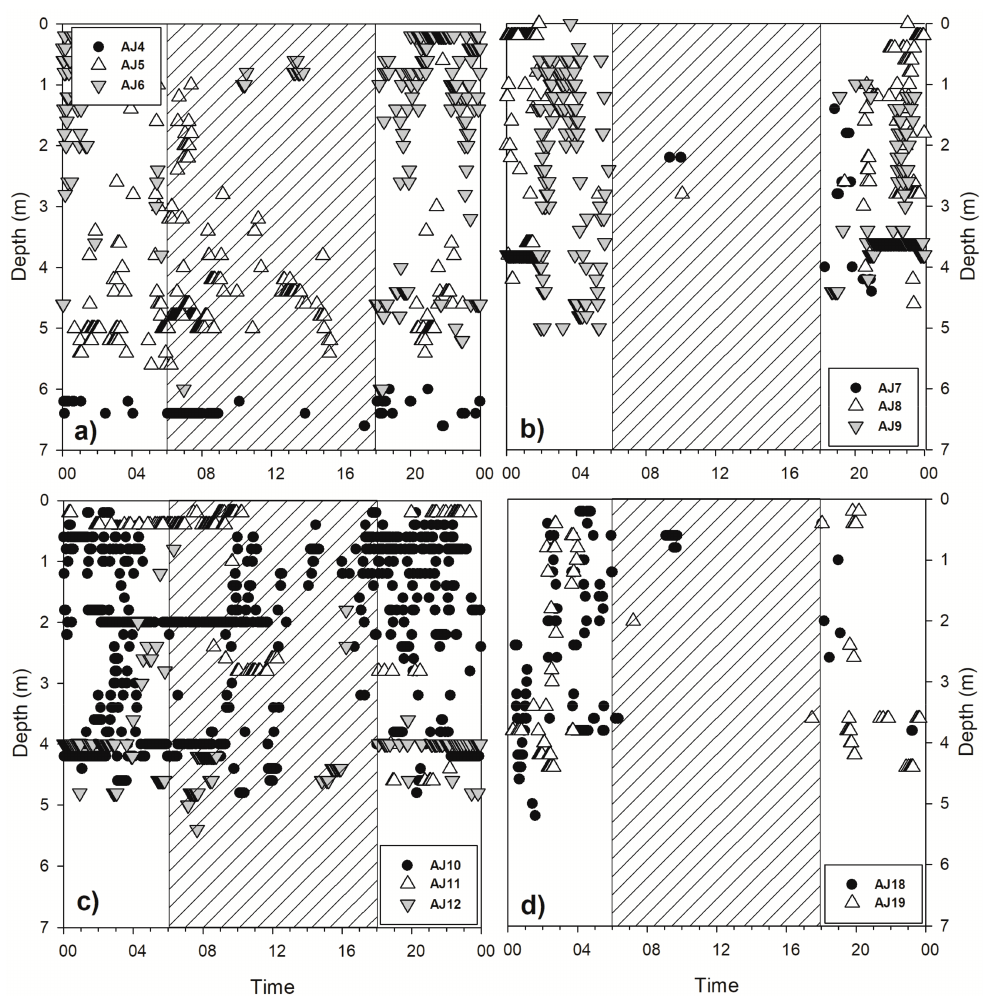
Figure 5. Average diel movement of 11 A. japonica fitted with a depth sensor; the diagonal line and white backgrounds represent nighttime and daytime based on average 12-h periods during 24 h, respectively. ( a ) AJ4, AJ5, AJ6, ( b ) AJ7, AJ8, AJ9, ( c ) AJ10, AJ11, AJ12, ( d ) AJ18,